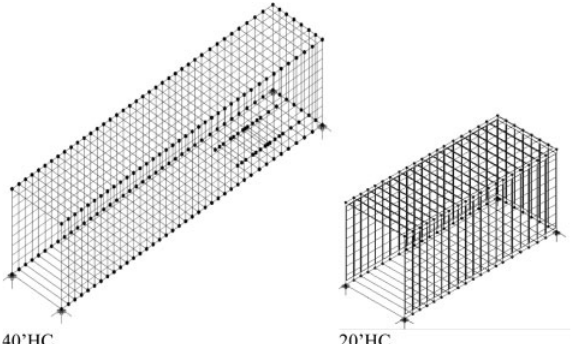
Fig. 5. Numerical model of the shipping containers